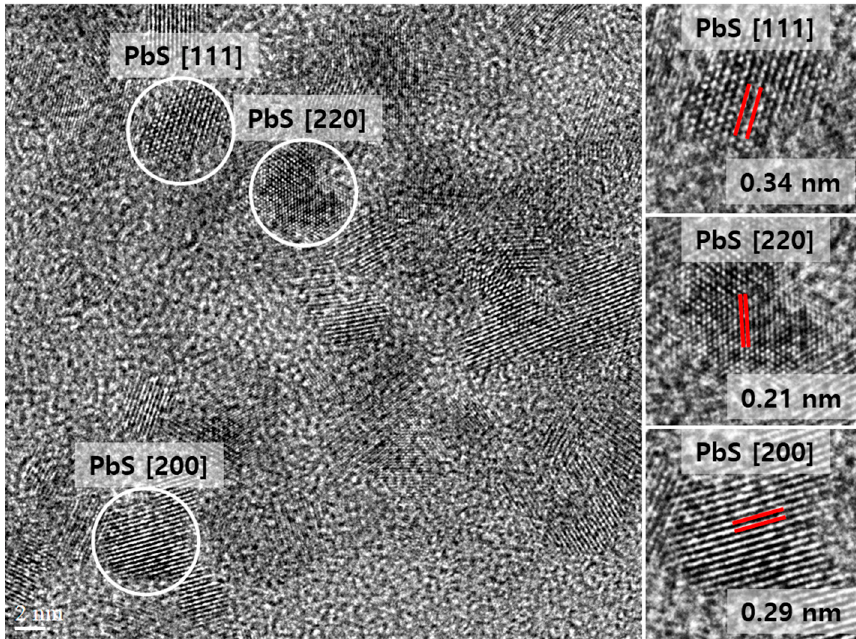
Figure 4. The TEM image of the synthesized quantum dots in a higher magnitude than in Figure 3. In the image, the particles are able to be classified by three types of lattice structures. The lattice plane spacing of the synthesized quantum dot are 0.21 nm, 0.29 nm, and 0.34 nm, which correspond to PbS [220], PbS [200], and PbS [111] .